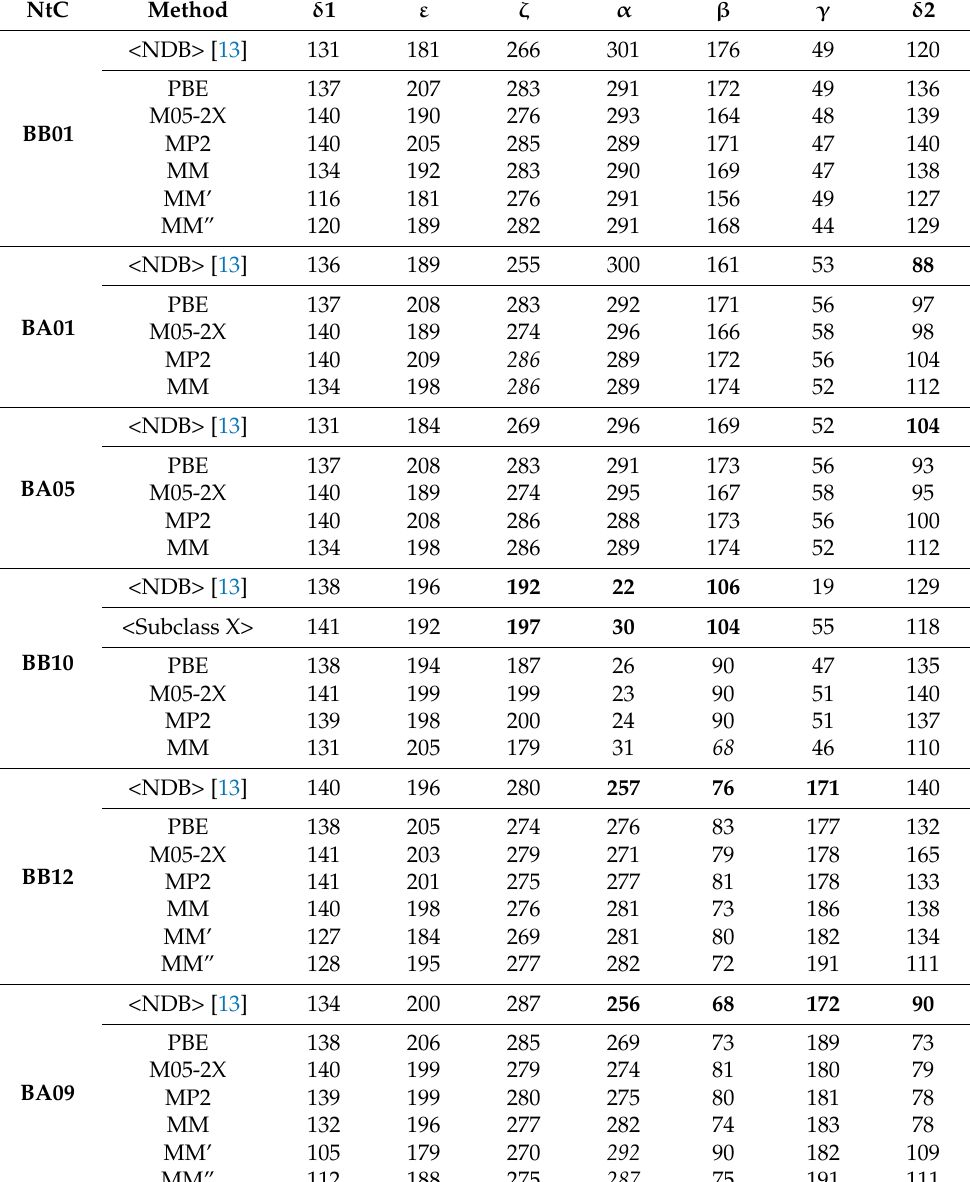
Table 3. Torsion angles of the sugar-phosphate backbone for conformational classes corresponding to the energy minima of separate SPB